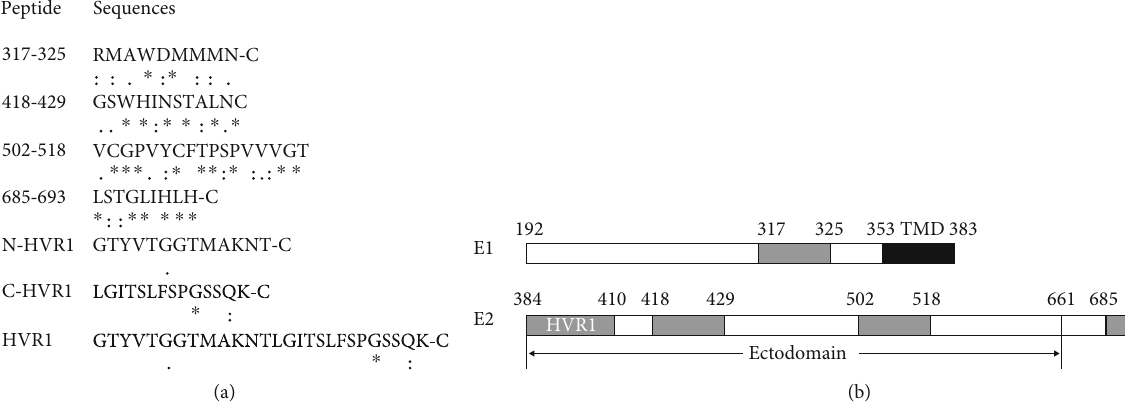
Figure 1: (a) Conservation analysis of segments within glycoproteins E1/E2. A total of 536 HCV sequences were submitted to Clustal Omega (http://www.ebi.ac.uk/Tools/msa/clustalo/) for alignment. An “ ∗ ” (asterisk) indicates positions that have a single, fully conserved residue. A “ : ” (colon) indicates conservation between groups of strongly similar properties, i.e., scoring > 0 : 5 , in the Gonnet PAM 250 matrix. A “ . ” (period) indicates conservation between groups of weakly similar properties, scoring ≤ 0 : 5 , in the Gonnet PAM 250 matrix. An extra cysteine residue was added to the C terminus of some peptides for conjugation with KLH. (b) Schematic diagram of the segments within glycoproteins E1/E2. TMD (black): transmembrane domain; HVR1: hypervariable region